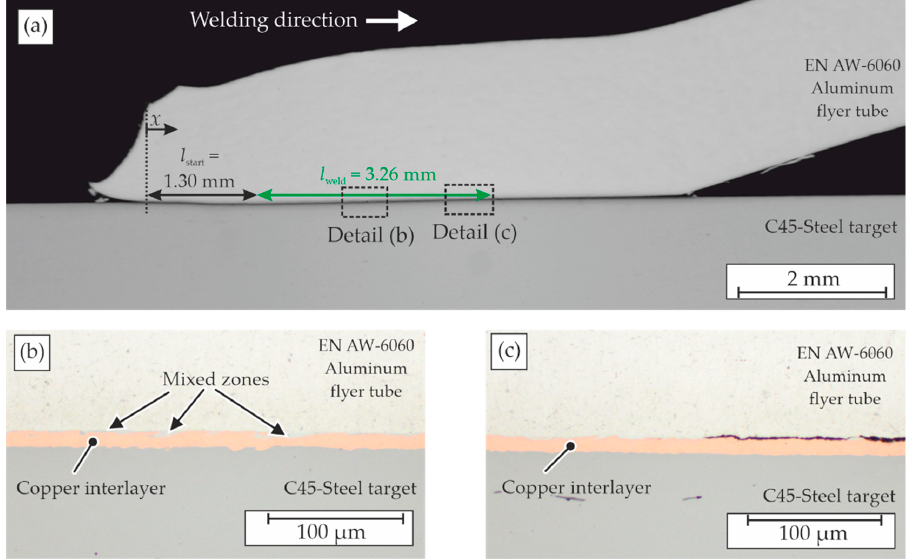
Figure 4. Cross sections of the MPW sample with E = 5.8 kJ and copper interlayer: ( a ) overview; ( b ) welded zone; and ( c ) end of the welded zone.